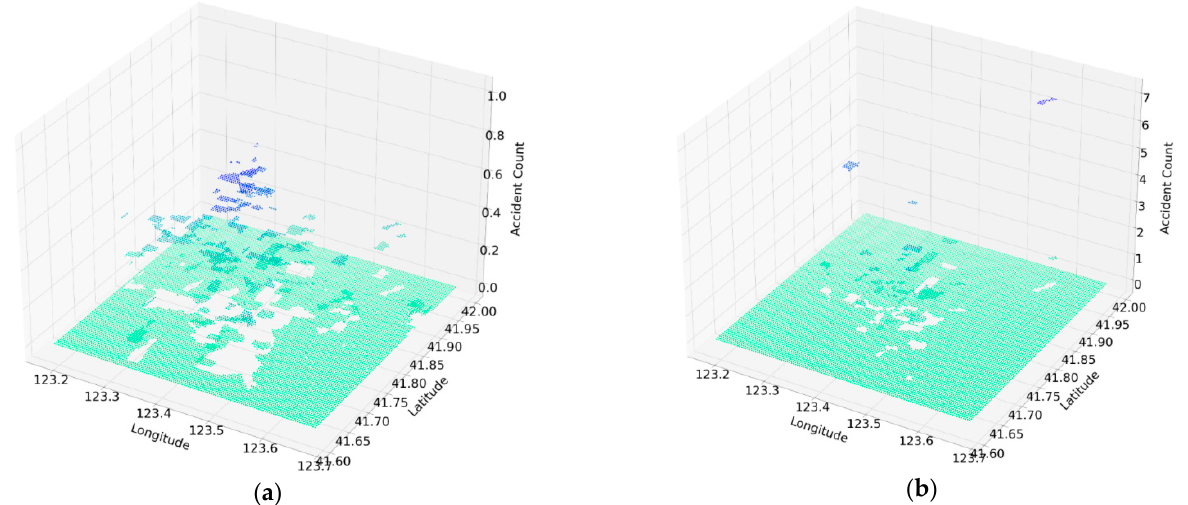
Figure 1. ( a ) The spatial distribution of the “traffic accident counts” indicator; ( b ) The spatial distribution of real traffic accidents.